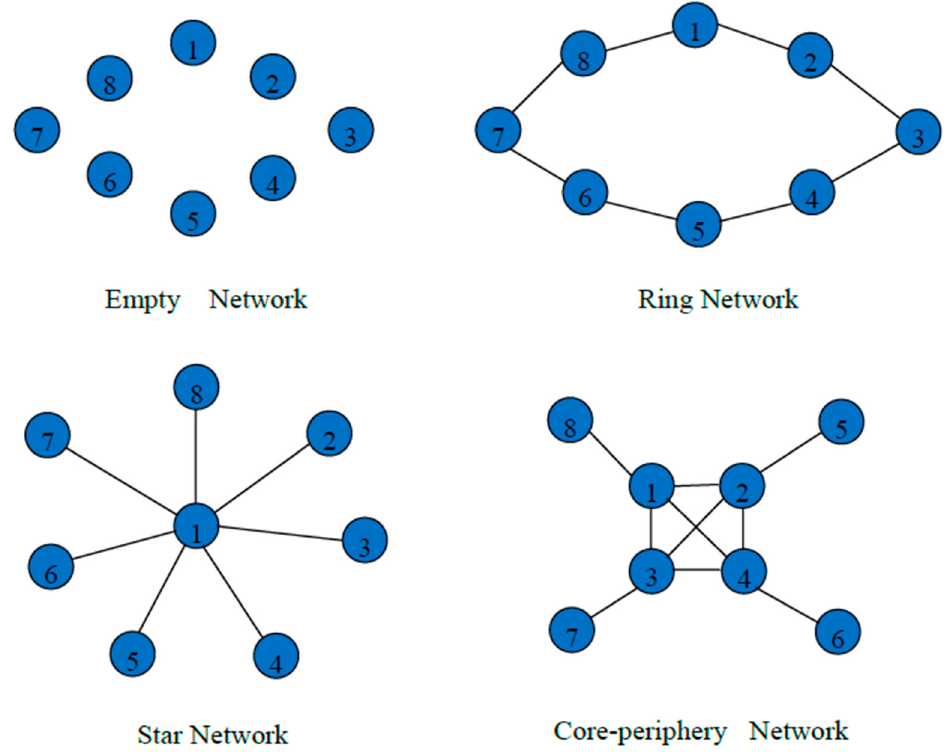
Figure 1. Four types of classical social networks.